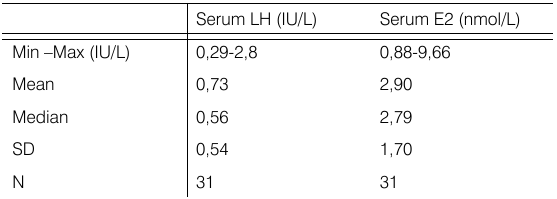
Table 1. Serum values of LH and E2.